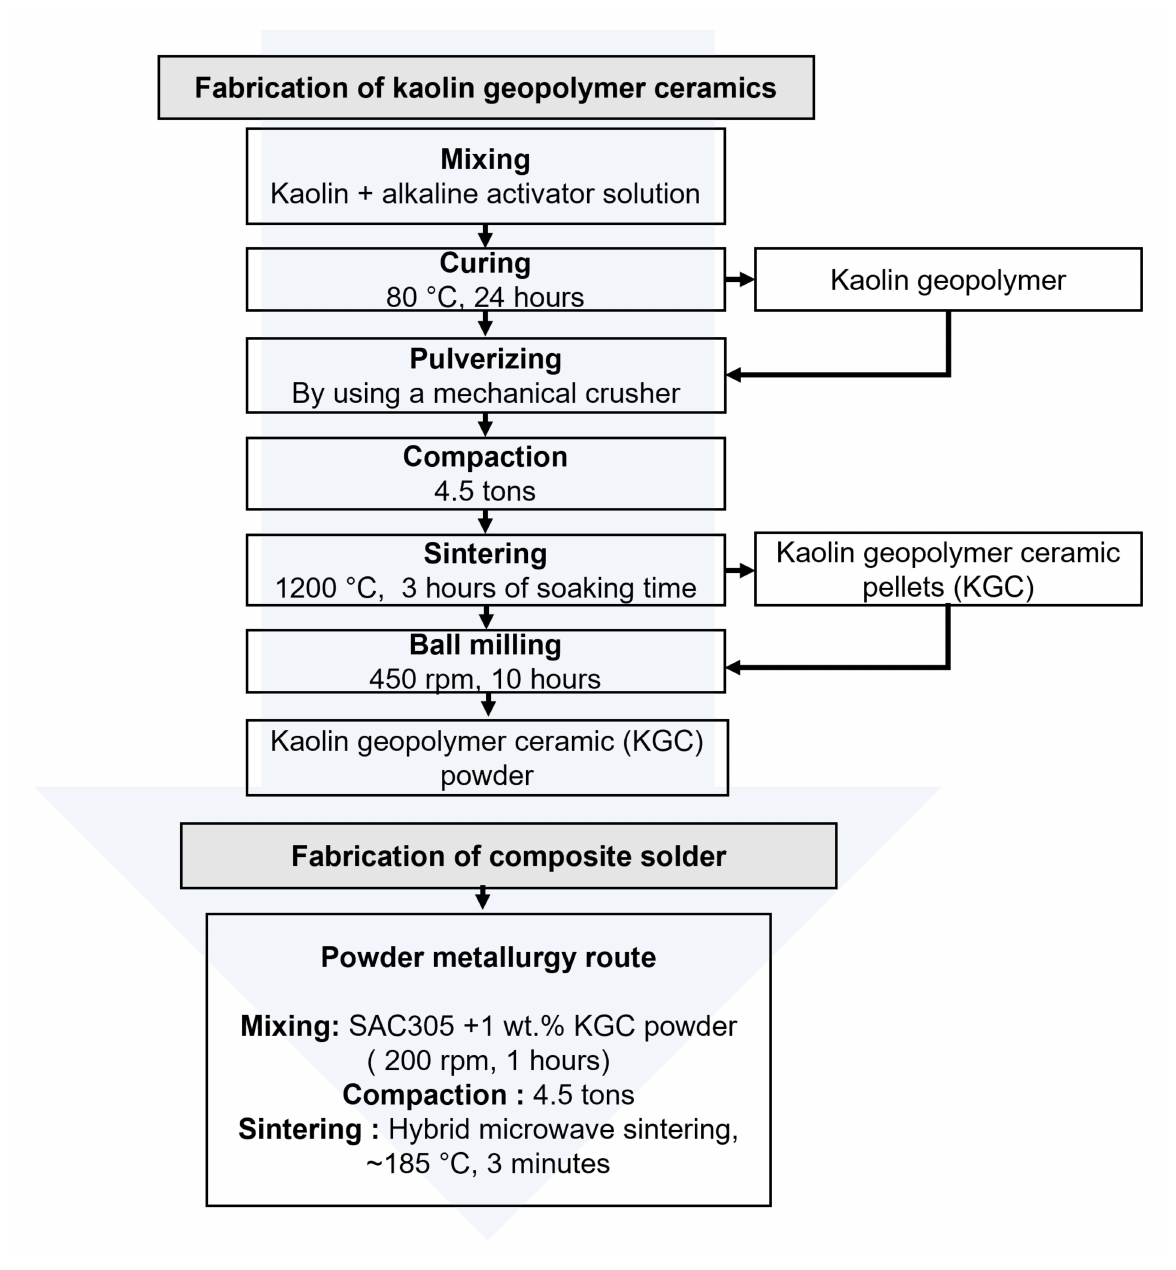
Figure 1. Fabrication process of kaolin geopolymer ceramics and composite